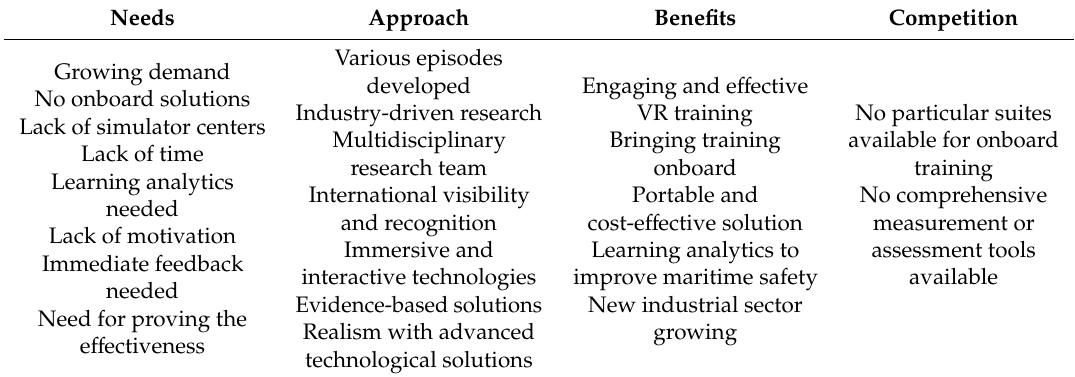
Table 1. Summary of the NABC